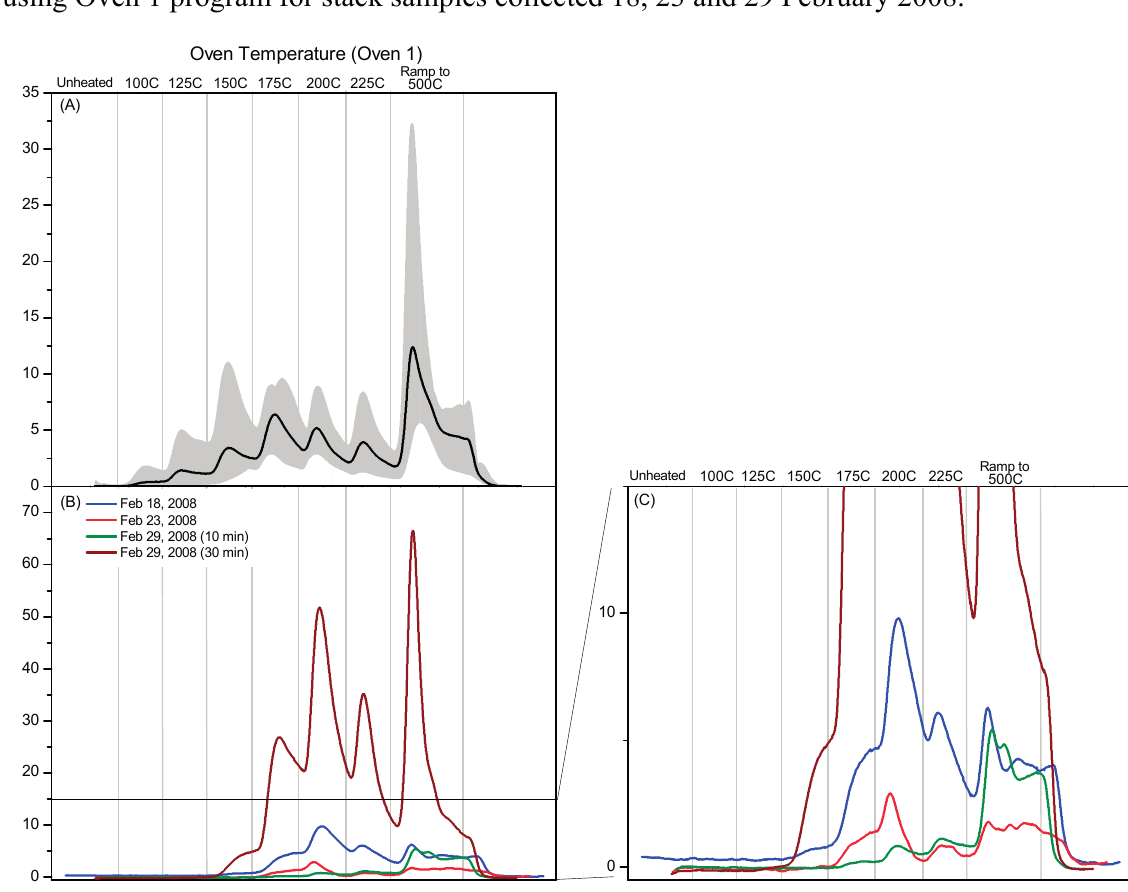
Figure 4. Panel ( A ): Calibration profile obtained from average of six PTD profiles using Oven 1 program for denuder loaded with pure HgCl . The grey shading spans the 2 minimum and maximum signals observed; Panels ( B , C ): Dissociation profiles obtained using Oven 1 program for stack samples collected 18, 23 and 29 February